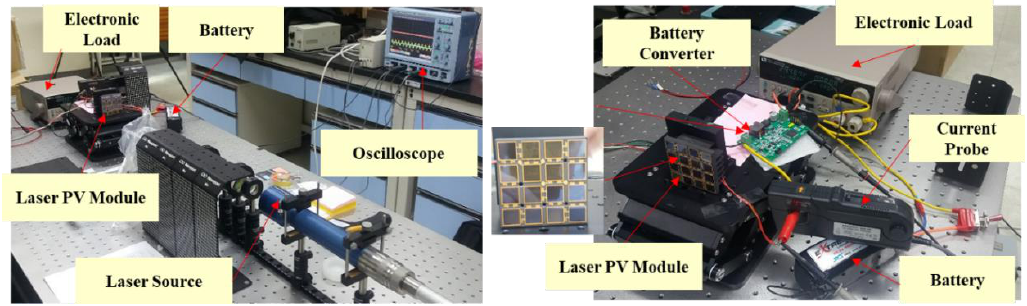
Figure 18. Experimental setup for laser wireless power transmission.